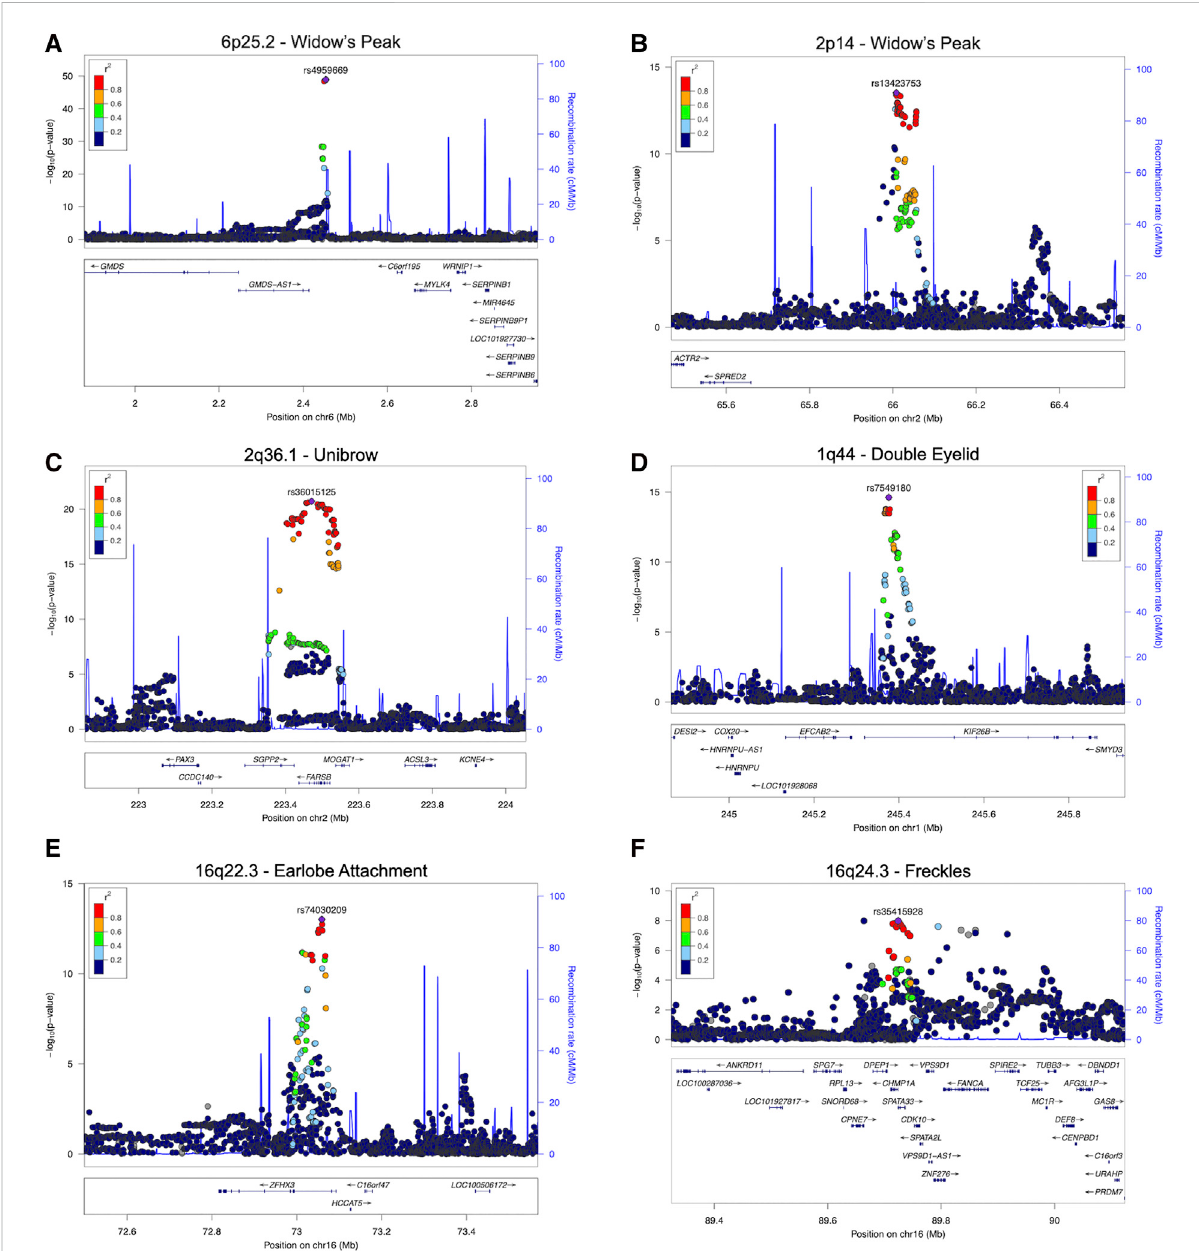
FIGURE 3 Regional association plots foreight regions with novel SNPsshowinggenome-widesigni fi cant associations withthe fi vefacial traits.Twonovel associations for widow ’ s peak and novel associations with the smallest p -values for unibow, double, eyelid, earlobe attachment, and freckles are shown (A) and (B) , Regional association plot for (A) 6p25.2 and (B) 2p14 with novel SNP showing genome-wide signi fi cant association with widow ’ s peak; (C) regional associationplotfor2q36.1 showingassociationwithunibrow; (D) regionalassociationplotfor1q44showingassociationwith double eyelid; (E) regional association plot for 16q22.3 showing association with earlobe attachment; (F) regional association plot for 16q24.3 showing association with freckles. SNP, single nucleotide